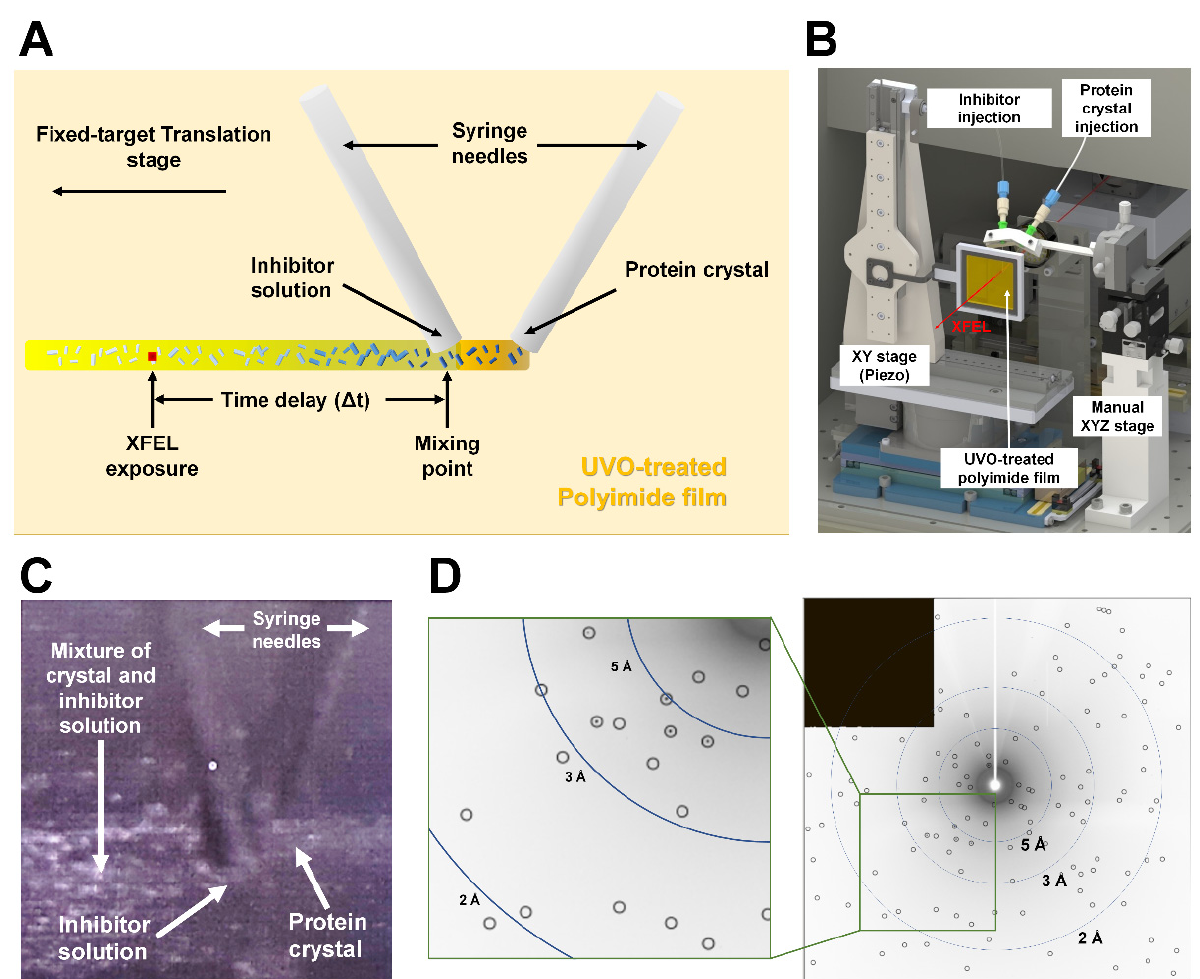
Figure 4. Preliminary data for inject-and-diffuse approach in the BITS system. ( A ) Schematic drawing of the sample loading in the inject-and-diffuse approach. ( B ) Schematic of the inject-and-diffuse system in the BITS. This experiment was performed before upgrading the injection needle stage; thus, the manual XYZ stage was installed. ( C ) Snapshot of the inject-and-diffuse experiment during XFEL data collection. ( D ) Indexing of the XFEL diffraction image from a preliminary inject-and-diffuse experiment. The predicted Braggs peak positions are indicated by circles, which were generated by the CrytFEL program.